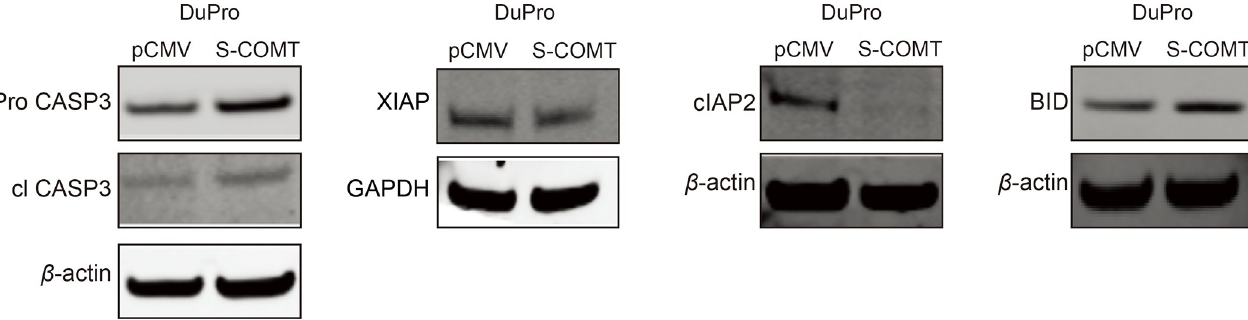
Fig 4. COMT affects apoptosis related genes in cells. Stable COMT-expressing and vector control DuPro cells were grown and expression of genes were determined by western analyses. Cleaved CASP3 and BID were observed to be increased whereas XIAP and cIAP2 genes were reduced. β -actin and GAPDH was used as loading